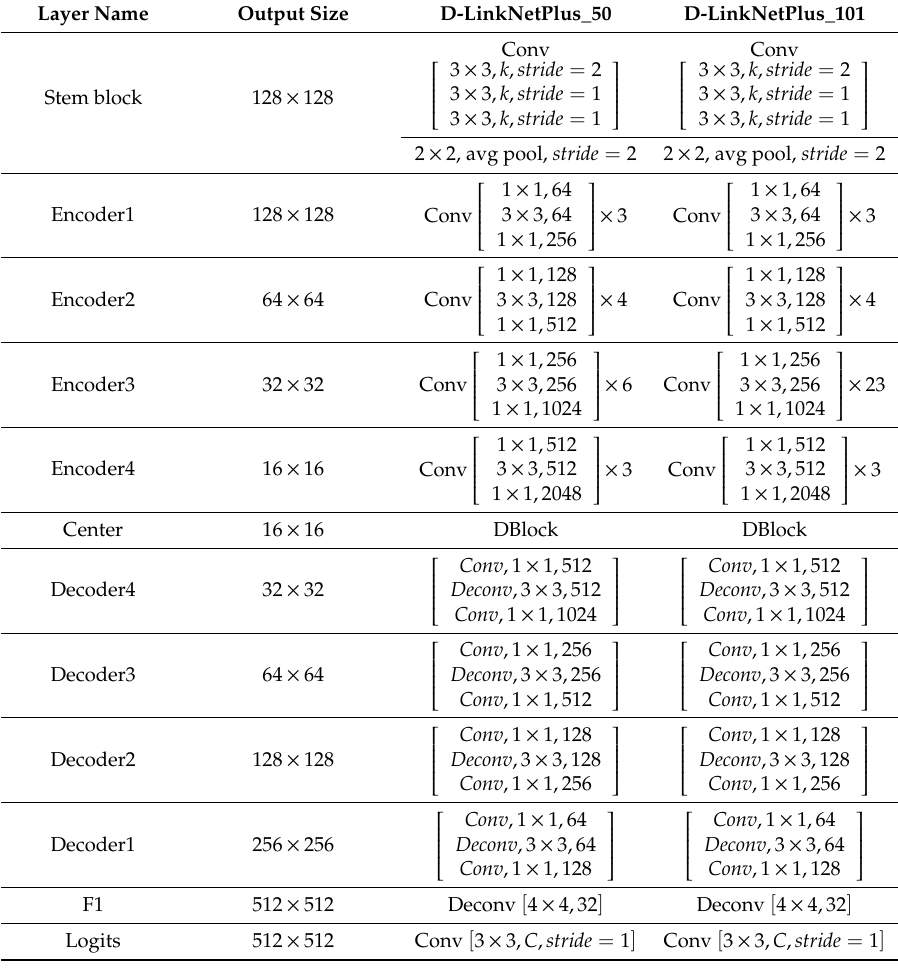
Table 1. D-LinkNetPlus structure parameters.